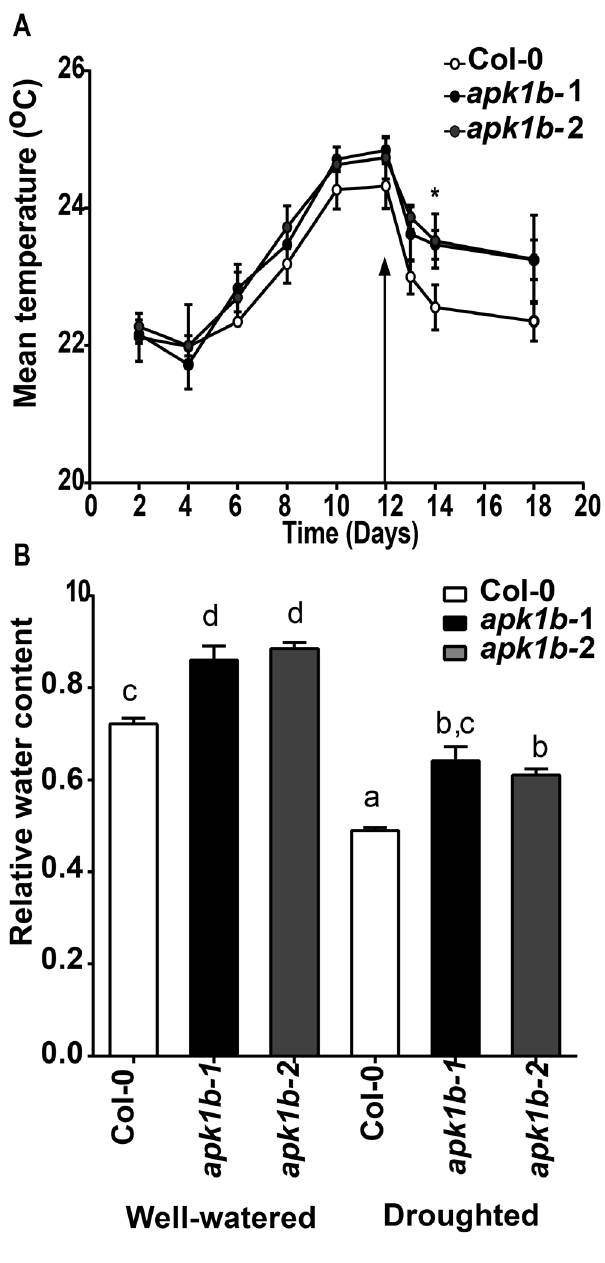
Figure 5. apk1b-1 and apk1b-2 have reduced levels of transpi- ration and increased relative water content in comparison to control plants. A: Temperature of the leaf surface following drought imposition for the time indicated was measured by infra-red thermography. The onset of watering is indicated by an arrow. Significant differences are indicated (*=p , 0.05). B: Relative water content was calculated from measurements of well-watered plants and plants subjected to 7 days of drought. Letters indicate significance groups (p , 0.05).